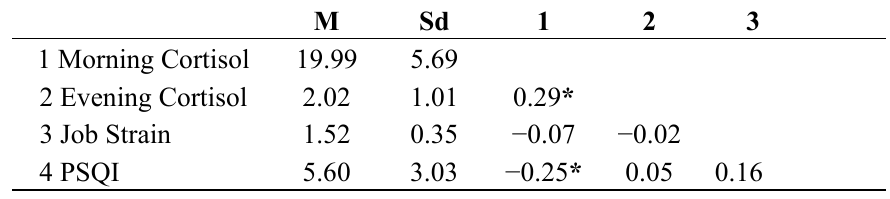
Table 1. Means and inter-correlations between morning and evening saliva cortisol secretion, job strain and sleep quality. (N = 76).